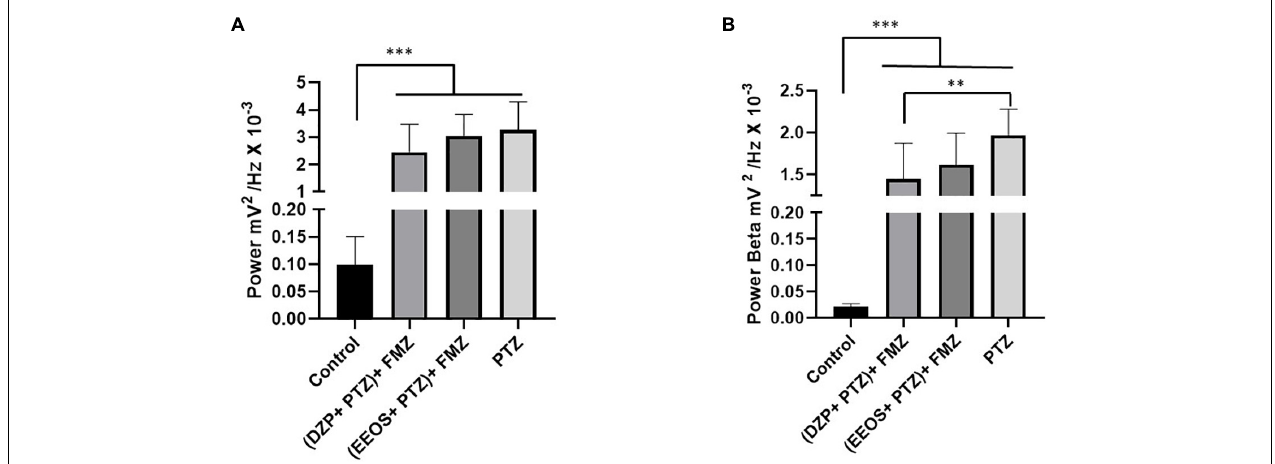
FIGURE 5 | Power in the records after flumazenil (FMZ) use (A) and the power of beta waves after FMZ administration (B) . The significant differences are shown in different letters in the columns after ANOVA followed by Tukey’s test ( ∗∗ p < 0.001; ∗∗∗ p < 0.0001, n = 9).